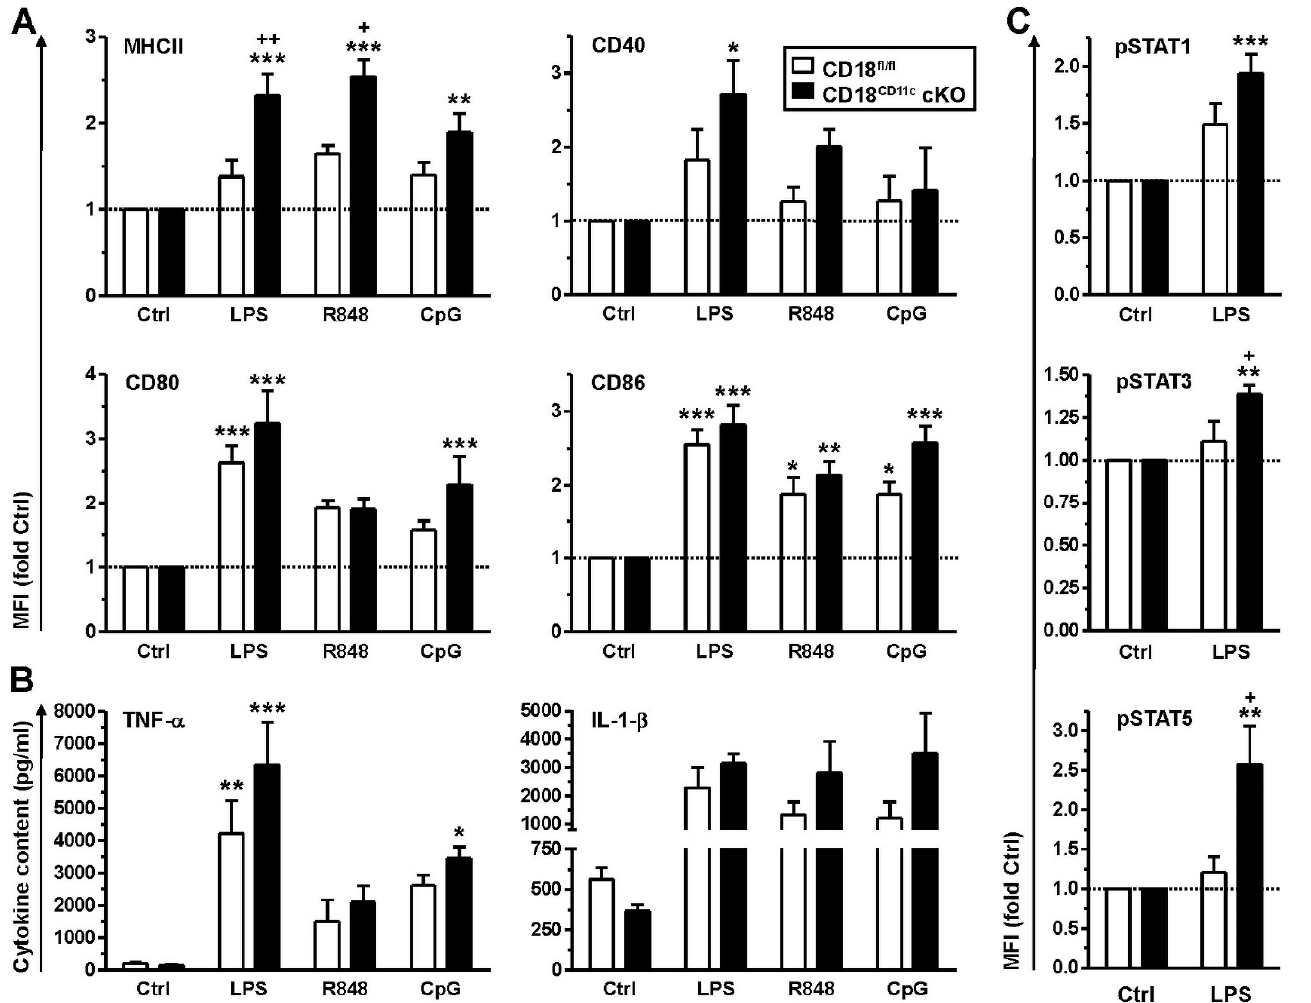
Figure 3. Bone marrow-derived DCs (BMDCs) with impaired β 2 integrin expression show elevated expression of some activation markers and cytokines, accompanied by enhanced activity of STAT-1, -3 and -5. BMDCs were differentially stimulated overnight. ( A ) Expression of surface activation markers was assessed by flow cytometry (gating strategy as described in [45]). Data are given relative to the expression of unstimulated cells (Ctrl) (mean ± SEM of 9–12 experiments). ( B ) Cytokine levels were quantified by CBA (mean ± SEM of 3–8 experiments). ( C ) BMDCs were stimulated with LPS for 1 h. Levels of phosphorylated (p)STAT proteins were quantified by intracellular flow cy- tometry (mean MFI ± SEM of 5 experiments, given relative to Ctrl). ( A – C ) Statistical differences versus * CD18 fl/fl (Ctrl) and + CD18 fl/fl under same conditions are indicated (one-way ANOVA, Tukey test). * ,+ p < 0.05, ** ,++ p < 0.01, *** p <0.001.